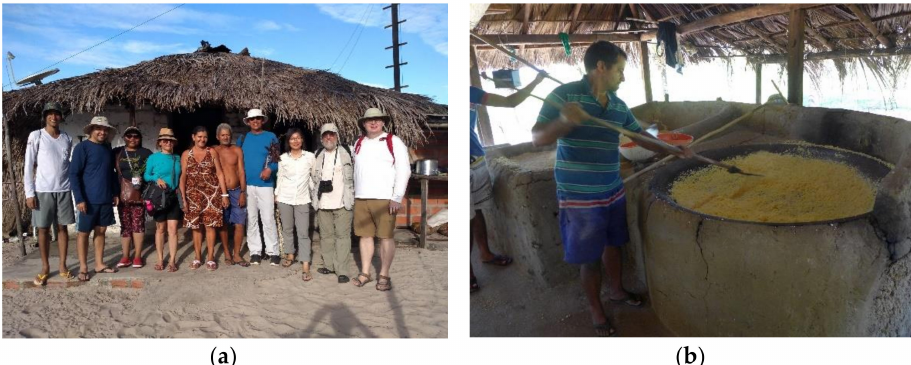
Figure 6. ( a )—Field activity in the community of Baixa Grande – Primitive Zone of Lenç ó is Maran- henses National Park. ( b )—Production of mandioca flour in the community of Mairizinho, municipality of Primeira Cruz—MA, located in the extreme western part of Lenç ó is Maranhenses National Park.